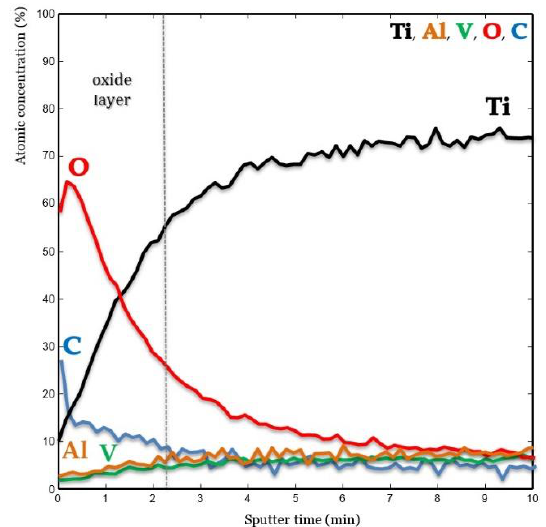
Figure 4. Concentration profile obtained by Auger electron spectroscopy (AES) and sputtering. Note the absence at the surface of a concentration of any of the alloying elements. On the contrary, a depletion of these elements was observed in the oxide layer of the implant surface.